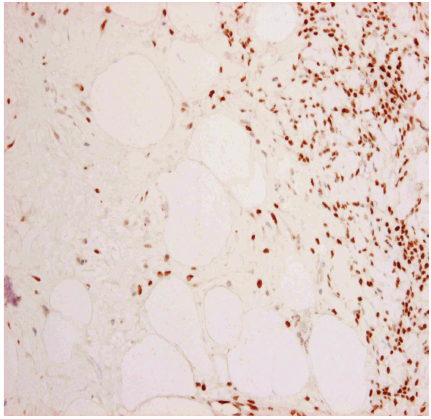
Figure 5: Mammary myofibroblastoma (MFB) with admixed but distinctspindlecelllipomacomponent.Spindlecellsofbothcompo- nents express androgen receptor (stronger in the MFB component), immunoperoxidase,